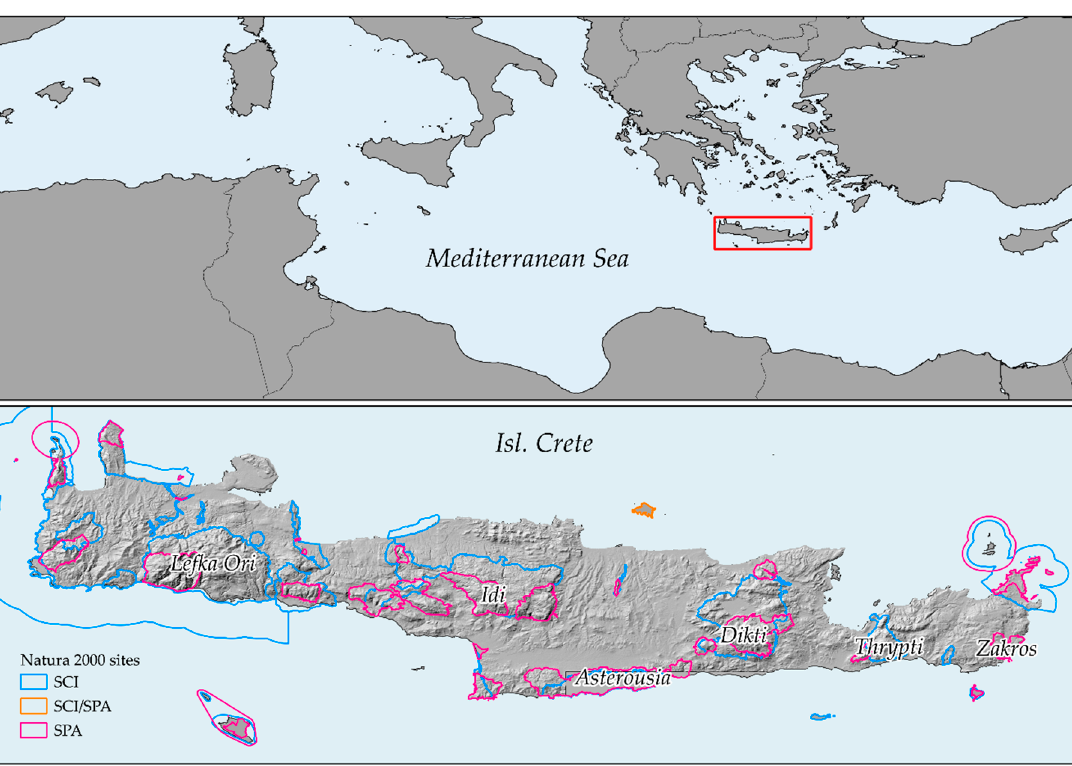
Figure 1. Map depicting Crete along with the areas designated as Natura 2000 sites. Asterousia, Dikti, Idi, Lefka Ori, Thrypti and Zakros constitute the main mountain systems in Crete. SCI: Sites of Community Importance. SPA: Special Protection Areas.